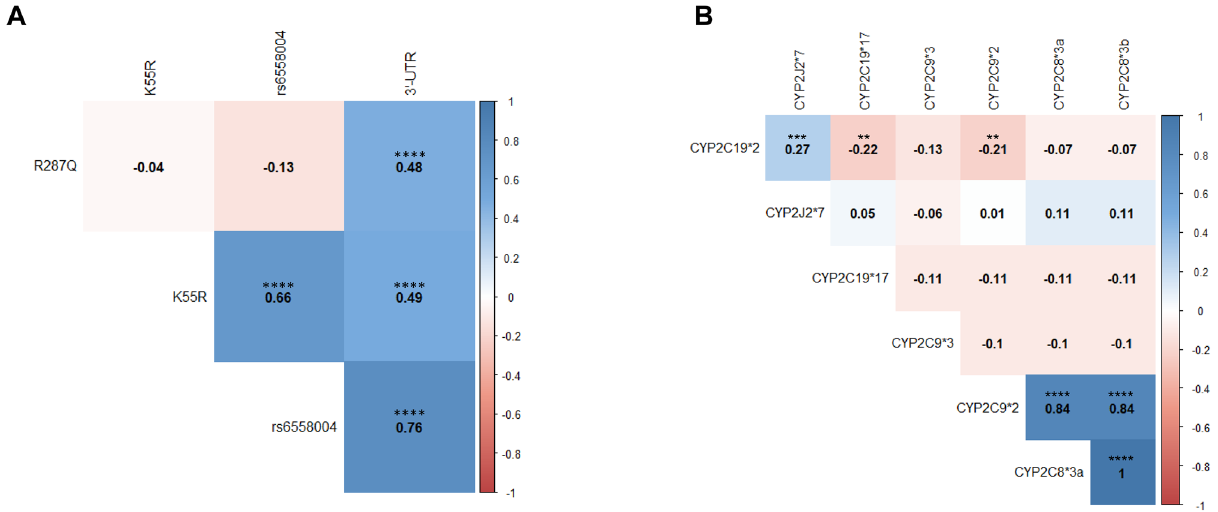
Figure 1. Correlation between the SNPs of EPHX2 ( A ) and CYP450 ( B ) determined in kidney transplant recipients. Pairwise linkage disequilibrium was expressed as correlation coefficient (r) determined using the following formula: r = − D/sqrt(p(A) * p(a) * p(B) * p(b)) with D, corresponding to the raw difference in frequency between the observed number of AB pairs and the expected number as follow: D = p(AB) − p(A)*p(B). P value is the Chi-square p value for marker independence.